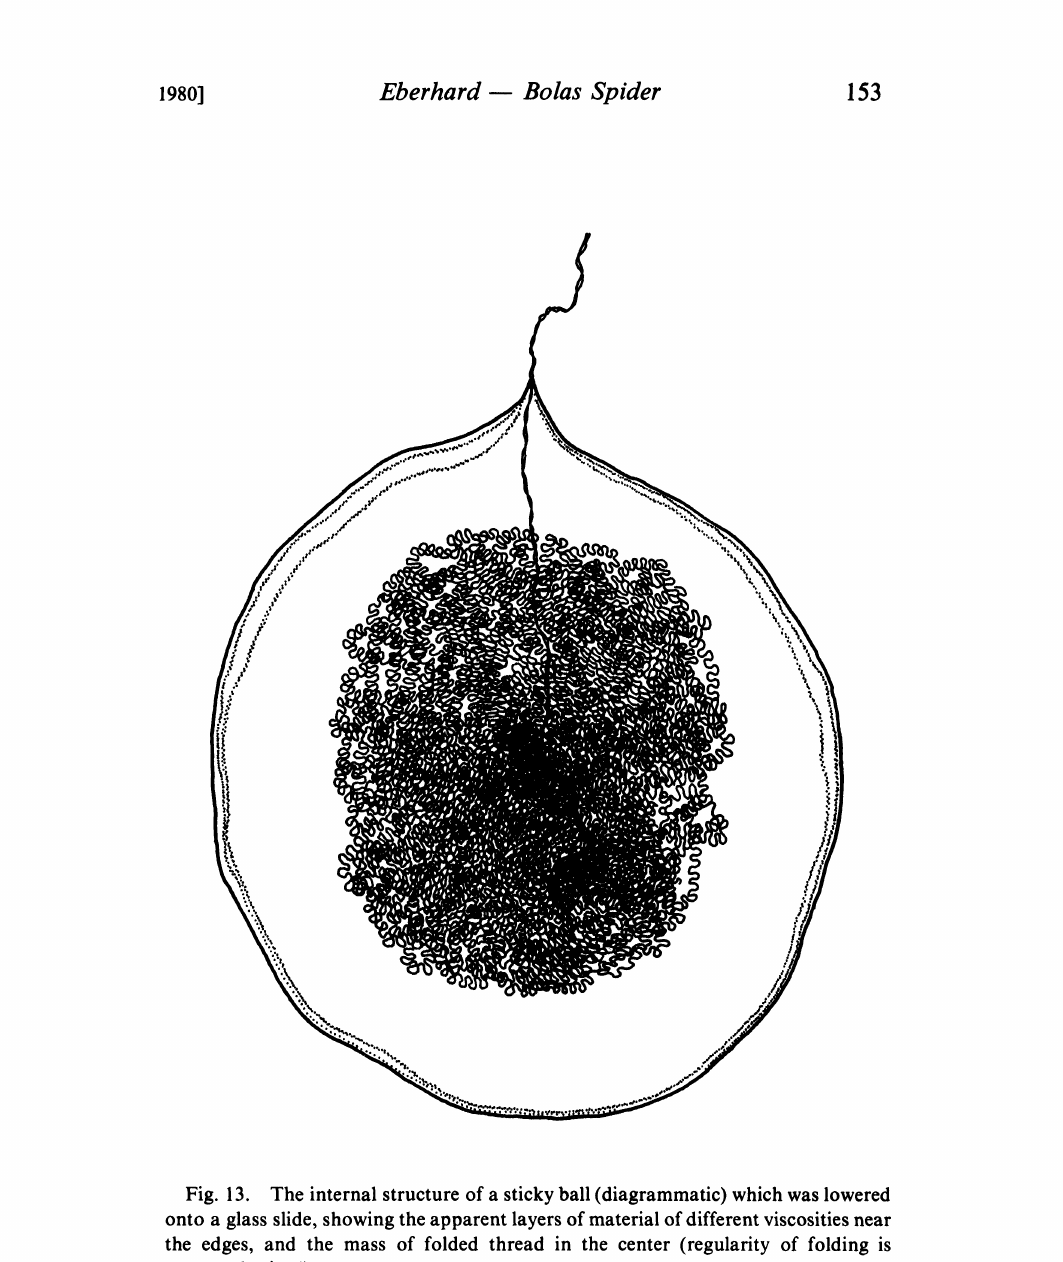
Fig. 13. The internal structure of a sticky ball (diagrammatic) which was lowered onto a glass slide, showing the apparent layers of material of different viscosities near the edges, and the mass of folded thread in the center (regularity of folding is